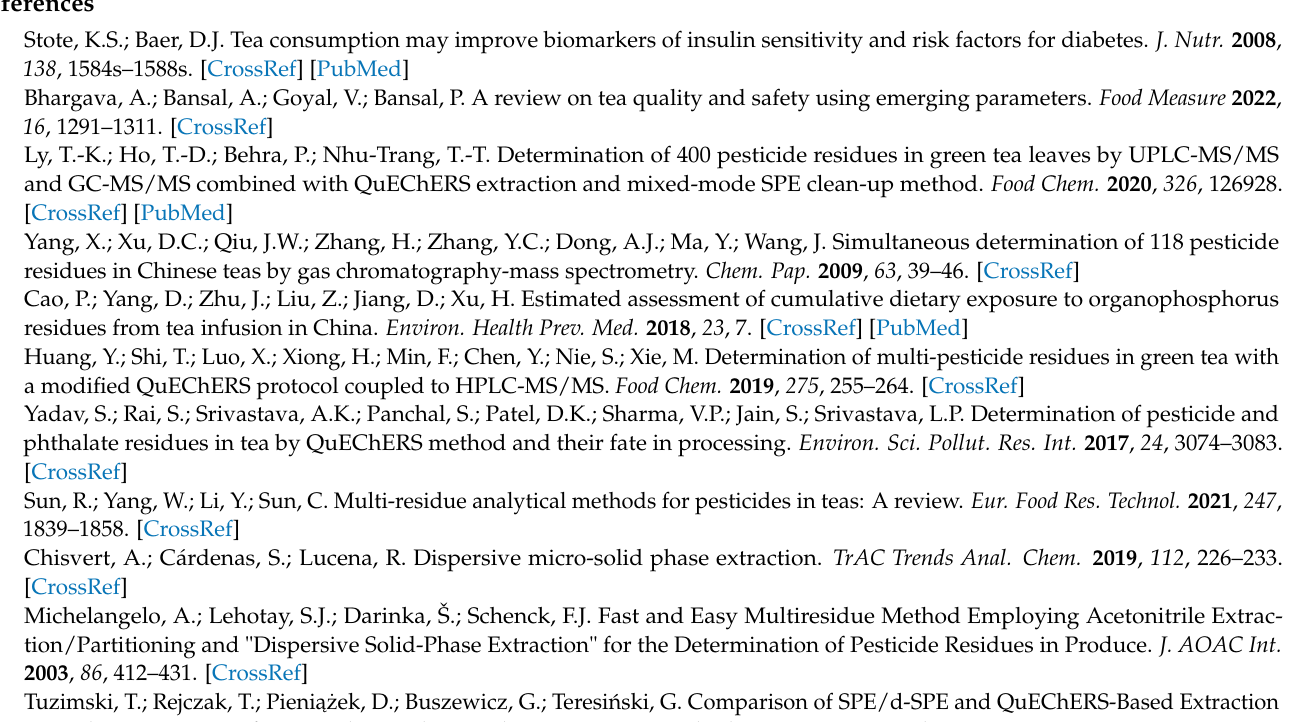
Table S1: Chemical information and Multiple Reaction Monitoring parameters for 21 pesticides; Table S2: The linearity and calibration curves of twenty-one